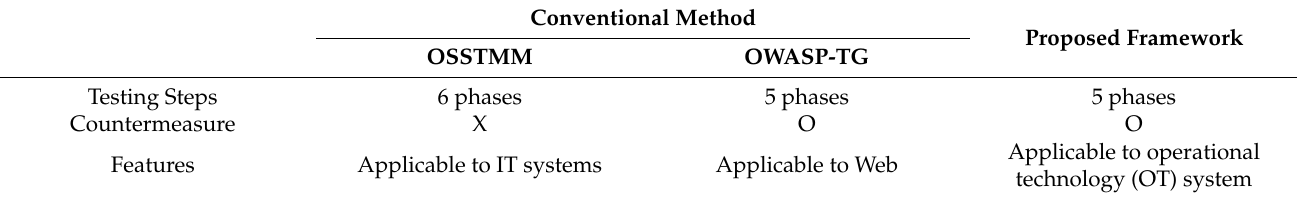
Table 20. Compare the conventional and proposed